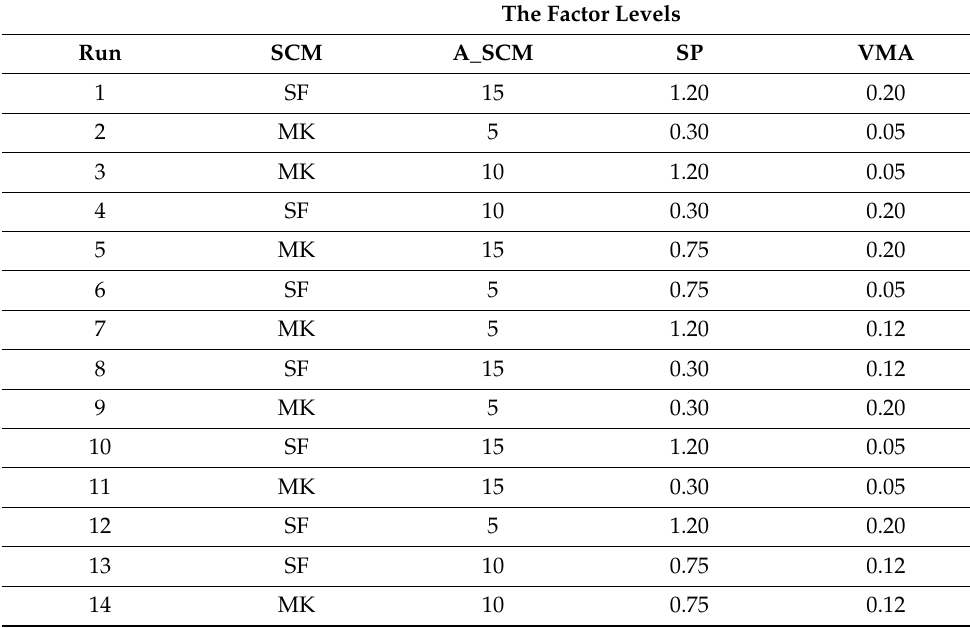
Table 4. Design matrix of all